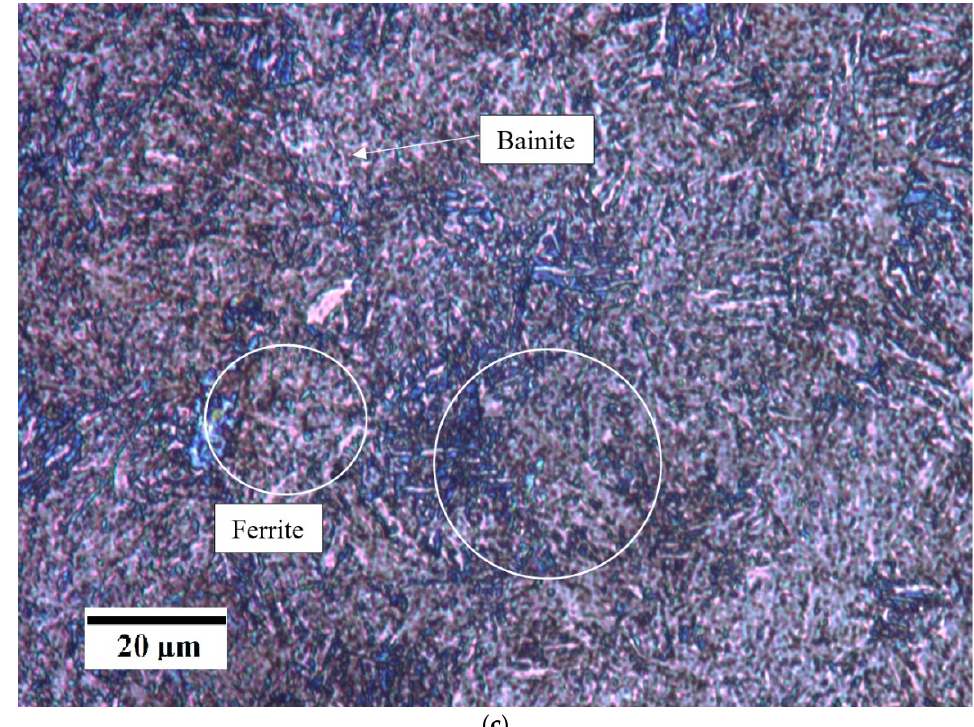
Figure 5. Microstructure after ( a ) 2% Nital etching (200×), ( b ) 10% sodium metabisulfite etching (500×), ( c ) reagent LePera etching–OM (500×).